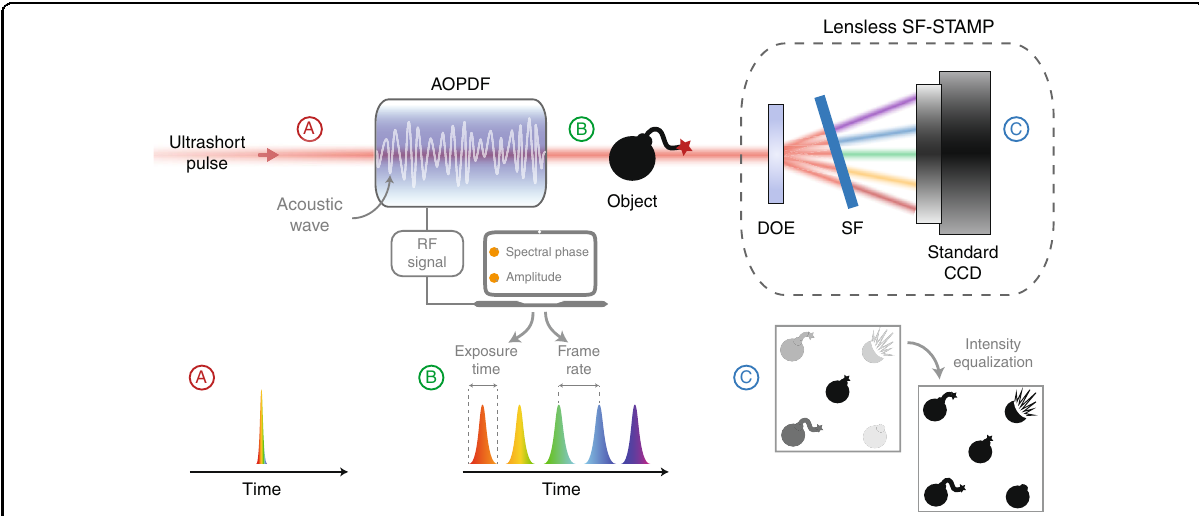
Fig. 1 Principle of operation. The acousto-optics programmable dispersive fi lter (AOPDF) tailors the pulse shape in both the spectral and temporal domains via its interaction with an electrically driven acoustic wave, then enabling the full and independent control over the exposure time and frame rate in the subsequent SF-STAMP detection scheme, comprising a diffractive optical element (DOE), a tilted spectral fi lter (SF) and a standard